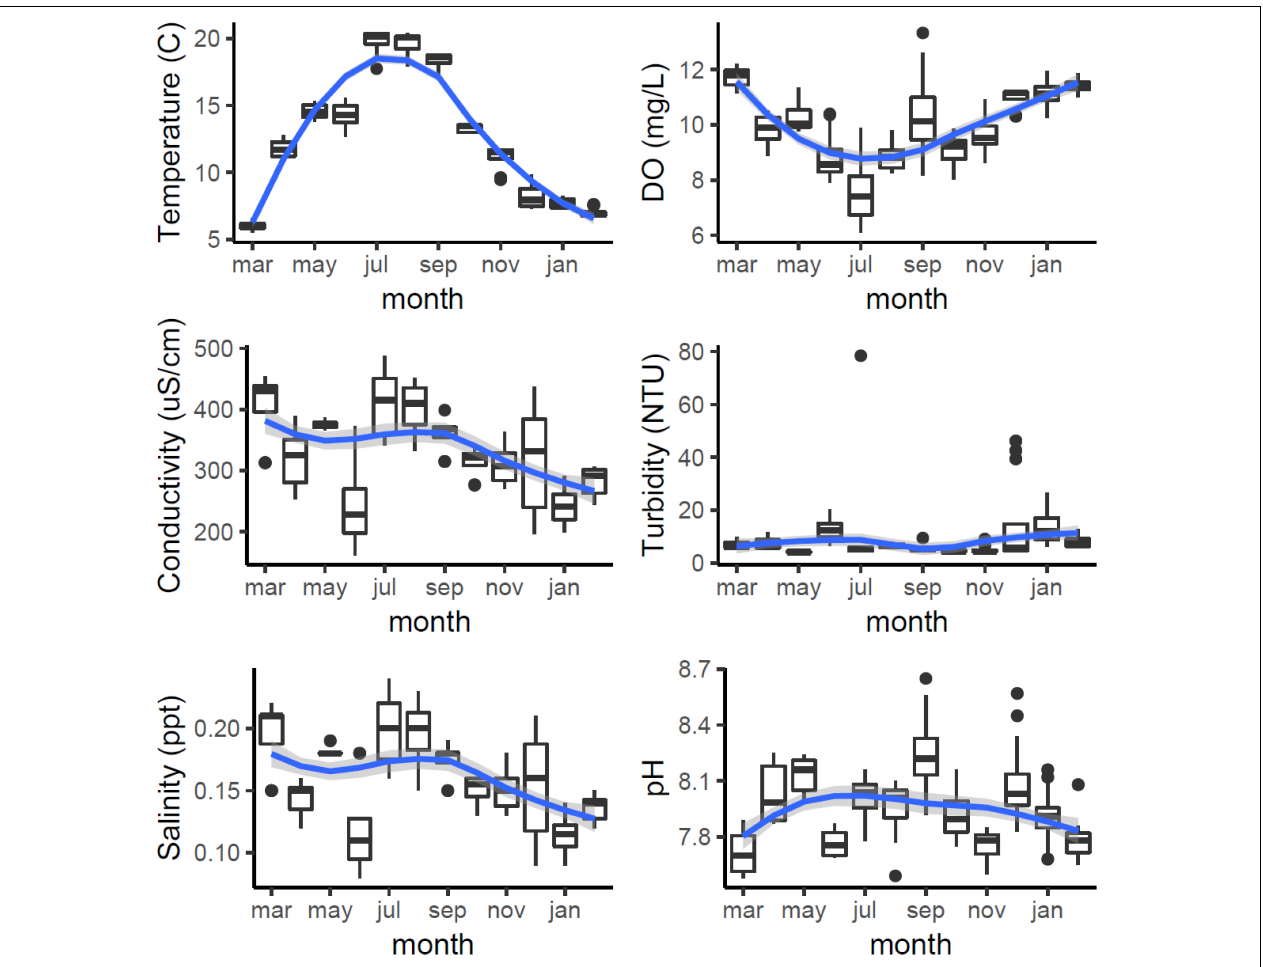
FIGURE 3 | Monthly variation in water chemistry in Cardiff Bay during the course of the study showing median values and interquartile range (boxplots) and smoothed fitted trends with 95CI envelopes (blue and gray bands).